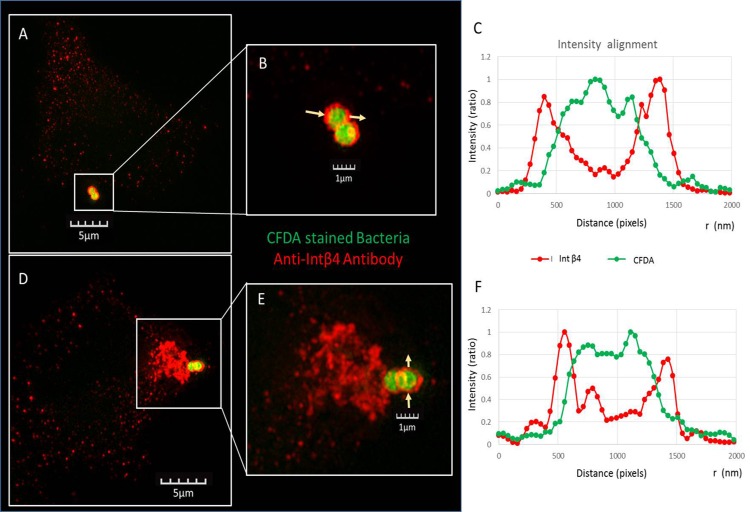
SIM images of CFDA-stained bacteria with Int β4 on A549 cells.CFDA-stained S. pneumoniae strain WU2 cells were incubated with A549 cells for 1 h. Excess bacteria were removed, and the culture was fixed with 4% para-formaldehyde and stained with a rabbit anti Int β4. Secondary antibody used was Alexa Fluor 594 (red) conjugated AffiniPure Goat Anti-Rabbit IgG (H+L). 3D SIM images were obtained with the Elyra SIM imaging system with a 63x oil objective (NA = 1.4); actual magnification of the image is as indicated in the scale bar. A) S. pneumoniae (CFDA 488 nm—green) adhering to A549 epithelial cells are seen coated by Int β4 (red). B) Higher magnification of bacteria (green) enveloped with Int β4 (red). C) Intensity alignment profile. D) Pedestal-like structure formed at the site of adherence of S. pneumoniae (green) to A549 cells recruits Int β4 (red). E) Higher magnification demonstrates the recruitment of Int β4 (red) to the pedestal-like structure underneath the adhered S. pneumoniae (green). F) Intensity alignment profile.